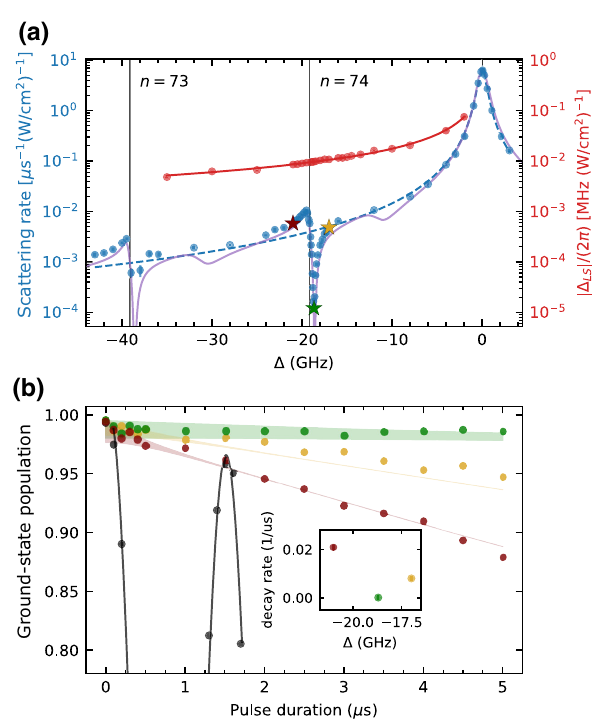
FIG. 4. (a) | (cid:3) LS | /( 2 π) (red) and (cid:4) LS (blue) for the 6 s 75 s 3 S 1 state, as in Fig. 2 but over a broader range of detunings with a fit of (cid:4) LS (blue dashed line) and a MQDT model (purple line) of the autoionization spectrum described in Appendix B. The positions of the 6 p 1 / 2 ns states (black lines) and the detuning that minimizes the scattering rate (cid:3) min /( 2 π) = − 18.7 GHz (green star) are indi- cated. (b) Rabi oscillations to | r (cid:3) (black, I c = 0) are strongly suppressed by applying the control field at detunings near (cid:3) min [the colors correspond to the starred points in (a)] and show good agreement with simulation (solid lines). We find that population decay (inset) from autoionization while light shifting the Ryd- berg state off resonance is suppressed below our experimental resolution when (cid:3) = (cid:3) min